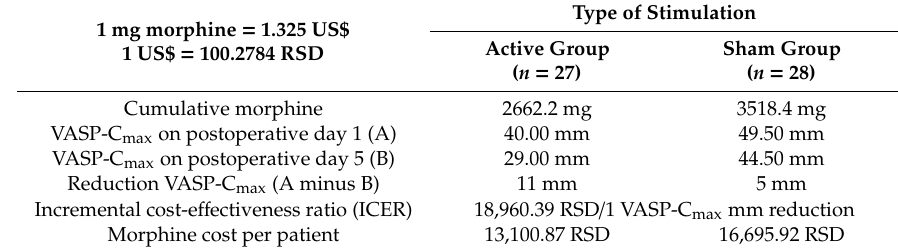
Table 2. Utility and expenditure of morphine cost data conversion from Serbian market to United States of America (USA) market, in the study population of patients where active or sham transcranial direct current stimulation was used for post-thoracotomy pain